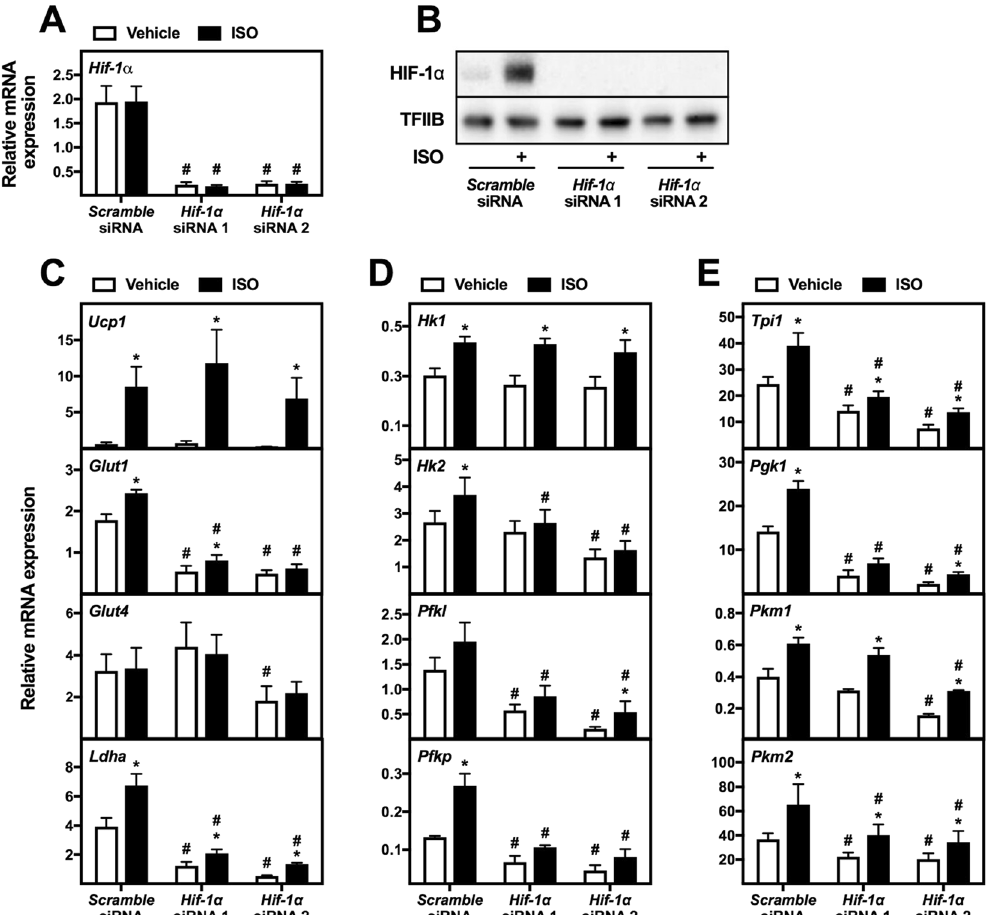
Figure 5. Involvement of HIF-1 α in regulation of expression of genes associated with glycolysis in a brown adipocyte cell line. Mature brown adipocytes (WT-1) were reverse transfected with two different siRNAs against Hif-1 α at day 6 after initiation of differentiation. Mature cells at day 10 were treated with vehicle (white bars) or 0.1 μ M ISO (black bars) for 12 h. Total RNA was harvested and analyzed by RT-qPCR (n = 3). Relative gene expression was measured for: ( A ) Hif-1 α ; ( C ) Ucp1 , Glut1 , Glut4 and Ldha ; ( D ) Hk1 , Hk2 , Pfkl and Pfkp ; ( E ) Tpi1 , Pgk1 , Pkm1 and Pkm2 . mRNA expression levels were normalized to Tbp . Data represent mean of means + SEM. * p < 0.05 versus vehicle-treated cells transfected with the same siRNA. # p < 0.05 versus scramble siRNA transfected cells treated in the same way (vehicle or ISO). ( B ) Immunoblotting analysis of HIF-1 α in brown adipocytes (WT-1) reverse transfected with scramble siRNA or two different siRNAs against Hif-1 α . Four days after the transfection, adipocytes were treated with vehicle or 0.1 μ M ISO for 3 h. TFIIB was used as loading control. Full-length blots for panel B are shown in Supplementary Figure